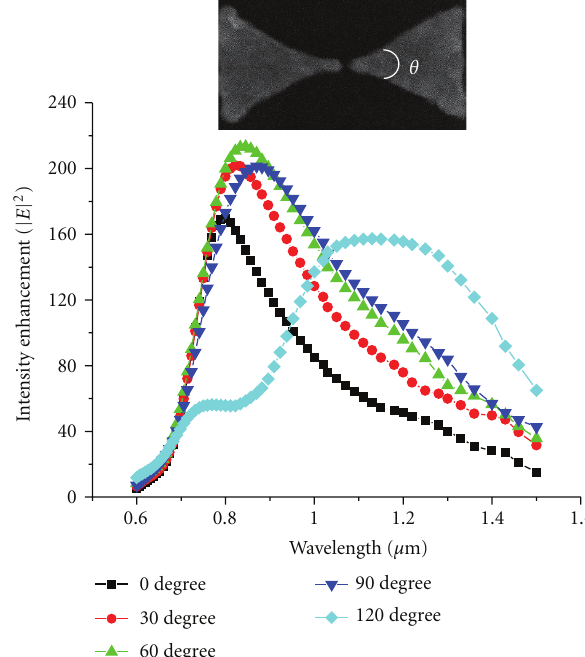
Figure 4: E -field intensity enhancement | E | 2 spectra of bowtie antennas with tip angles ranging from 0 degrees to 120 degrees. The inset shows a scanning electron microscopy (SEM) image of a bowtie antenna, denoting the tip